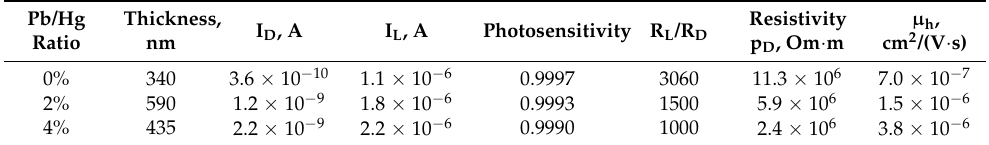
Table 1. Photoelectric parameters of HgTe-EDT:Pb NPLs